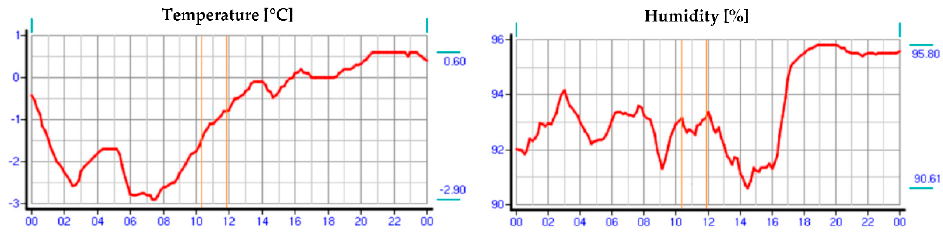
Figure 4. Temperature and humidity range on the day of the study (source: authors).